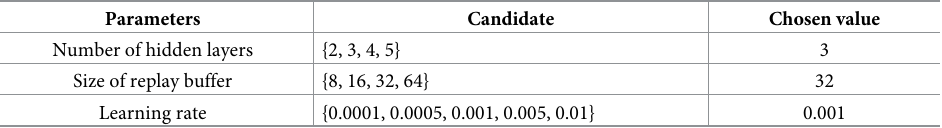
Table 2. Hyper-parameter settings for the RL model. (Written by authors).